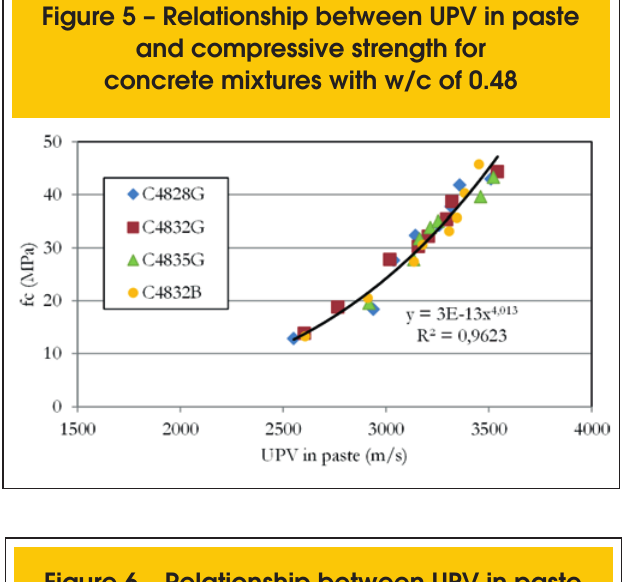
Figure 6 – Relationship between UPV in paste and compressive strength for concrete mixtures with w/c of 0.55